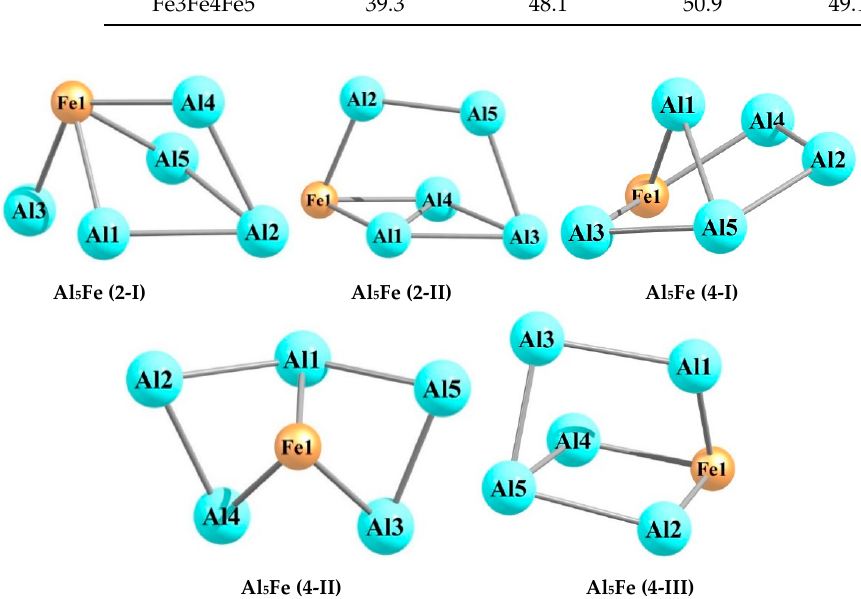
Table 3. Relative energies and spin multiplicities of the ground states of various structural isomers of metal clusters with an Al 4 Fe 2 composition . Structure